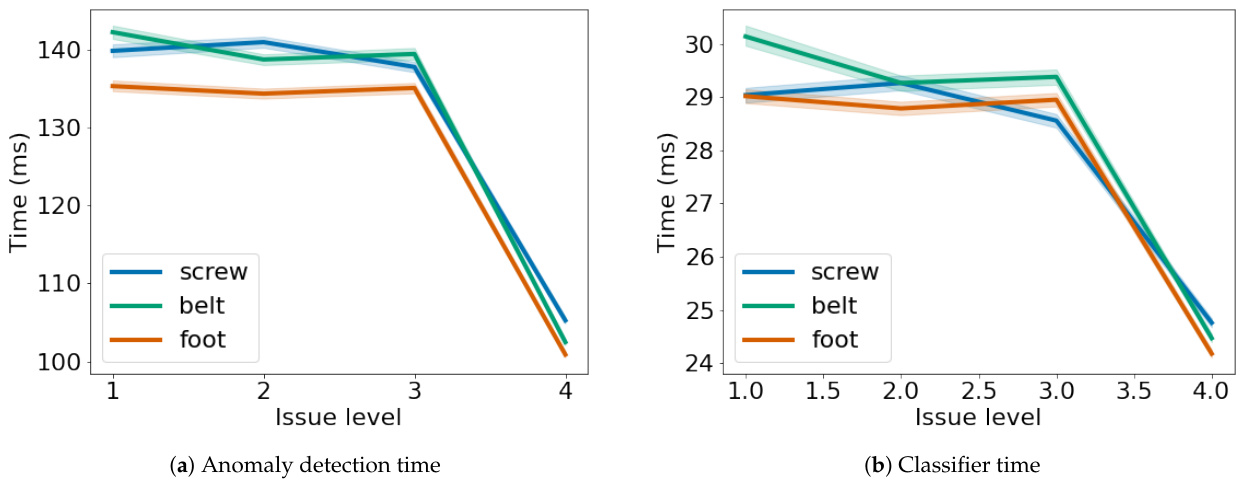
Figure 10. Time needed to perform the anomaly detection ( a ) and the classification ( b